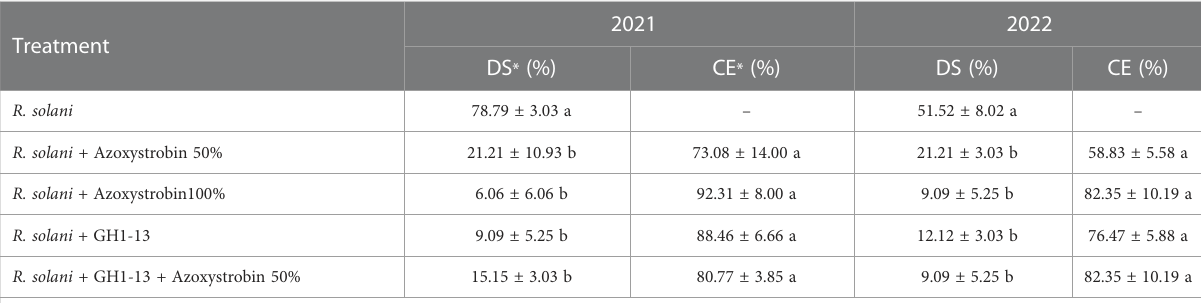
*DS andCE indicates disease severity and control ef fi cacy, respectively. Data ofdisease severity and control ef fi cacy usedin the table are the mean ±SE. Different lowercase letters after data indicate signi fi cant differences among treatments (p< 0.05). Values with the same letters are not signi fi cantly